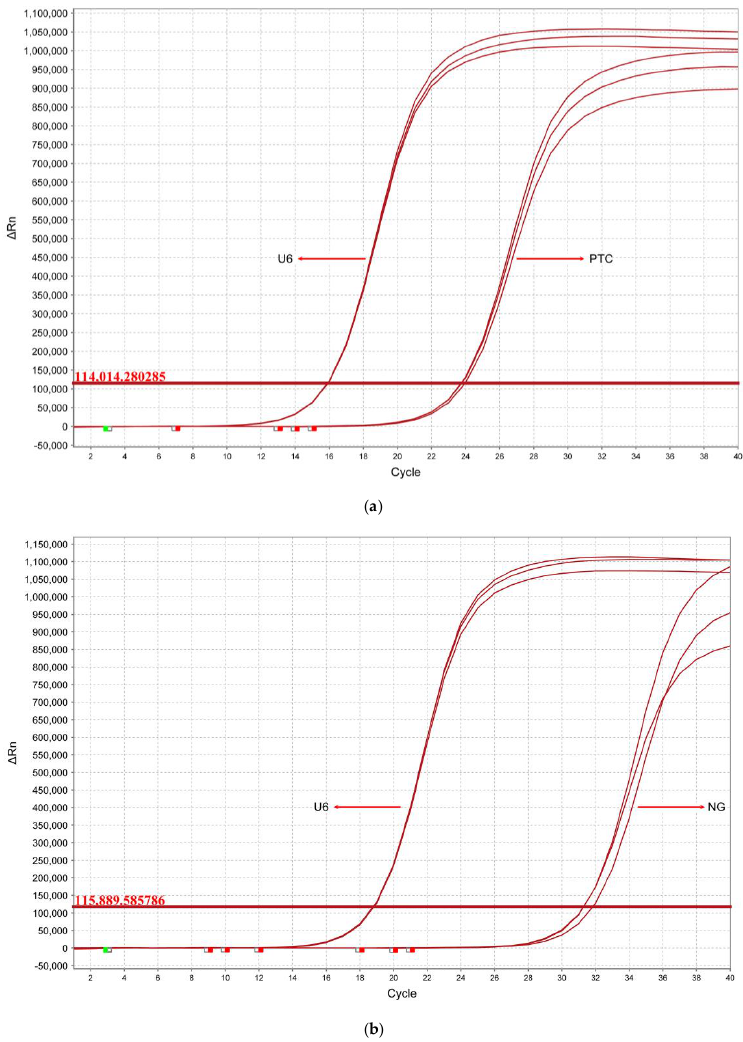
Figure 7. Typical qRT-PCR curves of the hsa-miR-146b-5p expressed in ( a ) PTC tissue and ( b ) NG tissue. U6 is the internal control sample.